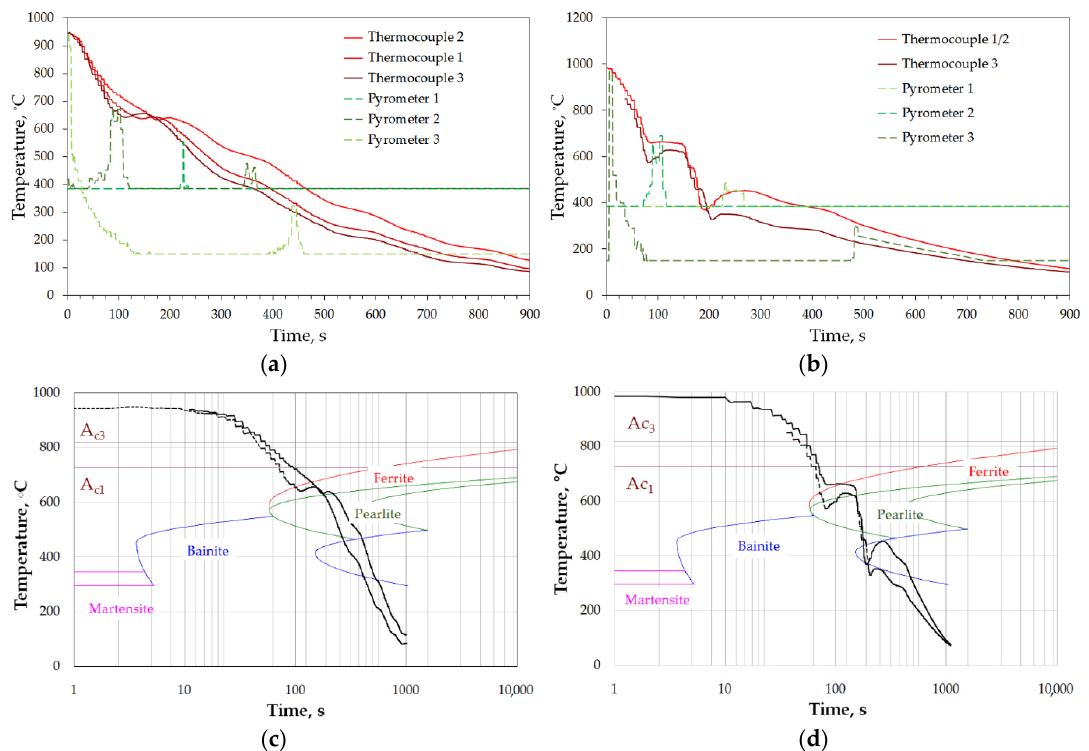
Figure 13. Temperature recorded during experimental tests of cooling with: ( a ) fan accelerated air of 45 m/s, ( b ) air-atomized water spray, and ( c , d ) the course of the obtained cooling curves of CTT diagram of steel 38MnVS6 for cooling with accelerated air, and spray, respectively, where: solid lines—T1/T2 and the dashed lines—T3/T4.